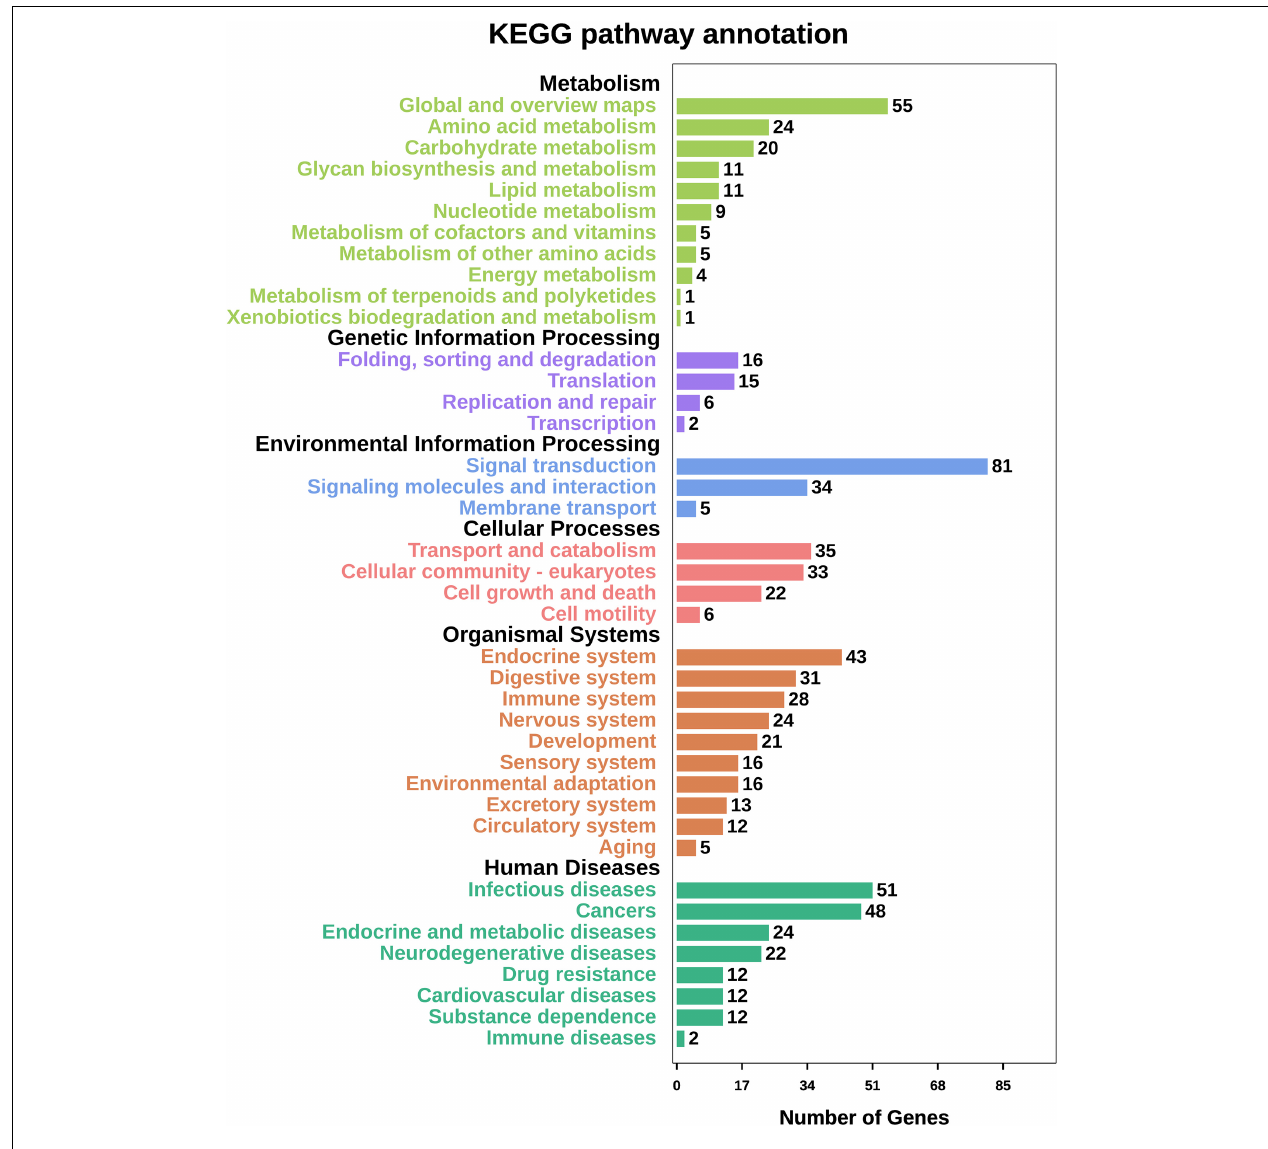
FIGURE 4 | The summary of KEGG pathway enrichment analysis performed for biological process, cellular component and molecular function. Functional annotation of candidate selective genes that comprised significant SNPs ( P <